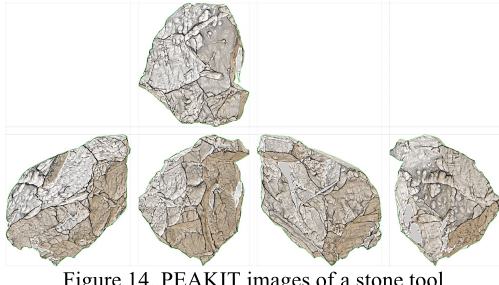
Figure 14. PEAKIT images of a stone tool (Mitaka City Board of Education, 2015)